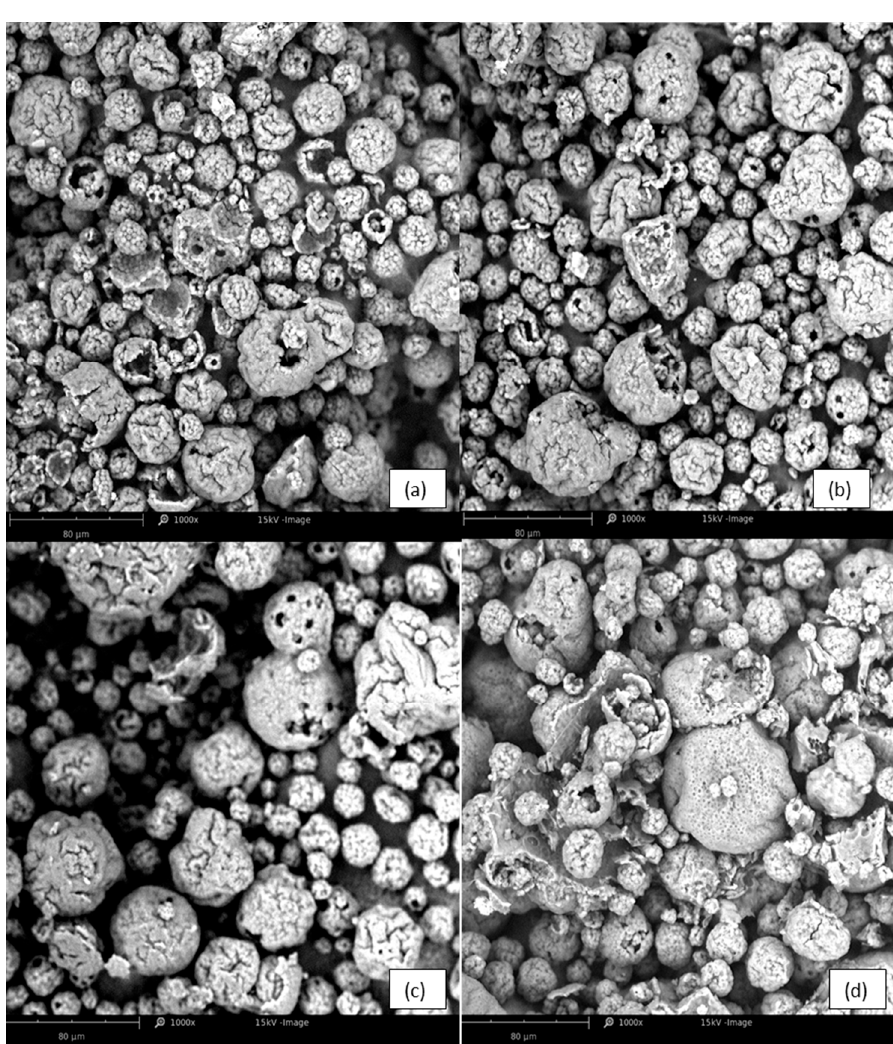
Figure A5. SEM image of dried Spirulina sp. after Soxhlet extraction by mixture of C:H:M at a ratio of ( a ) 1:1:1; ( b ) 2:1:3; ( c ) 3:2:1, and ( d ) 1:2:3 at 1000× magnification 15 kV.